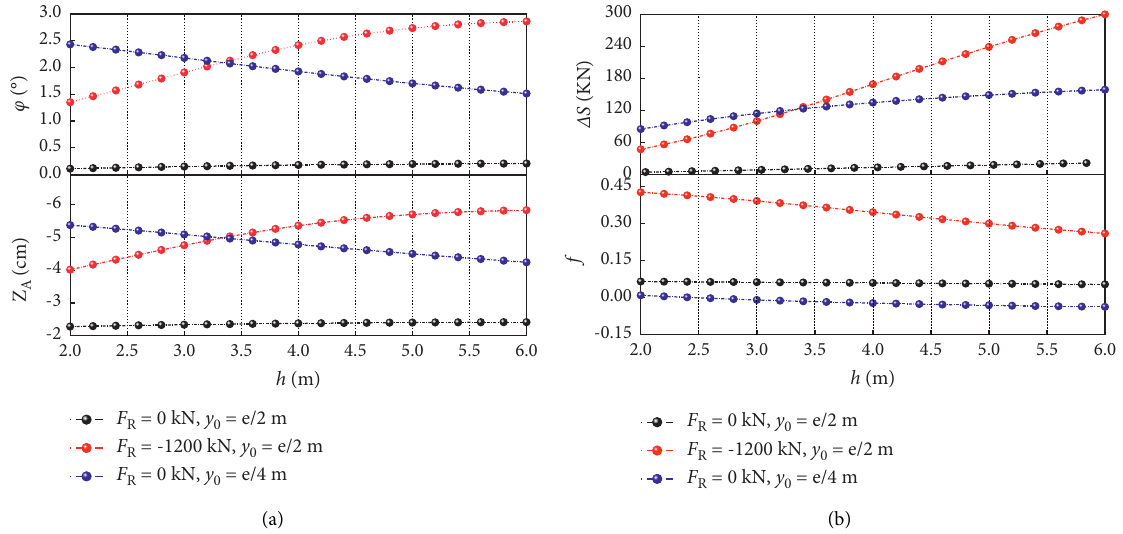
Figure 14: Influence of mining height on support stability ( p � 5,000kN). (a) Influence of mining height on support rotation. (b) Influence of mining height on support